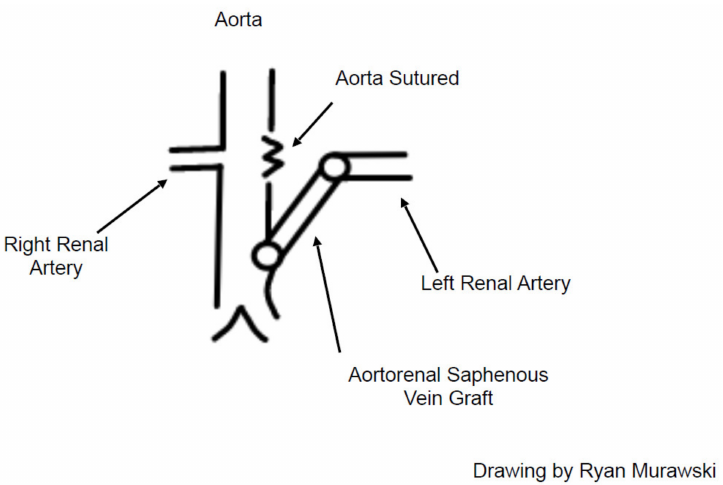
Figure 2. Schematic Drawing. Left Renal Artery Disruption and